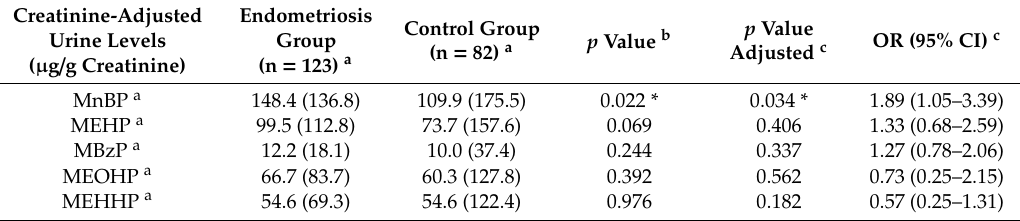
Table 2. Urinary levels of phthalate metabolites of endometriosis patients and control. Creatinine-Adjusted Urine